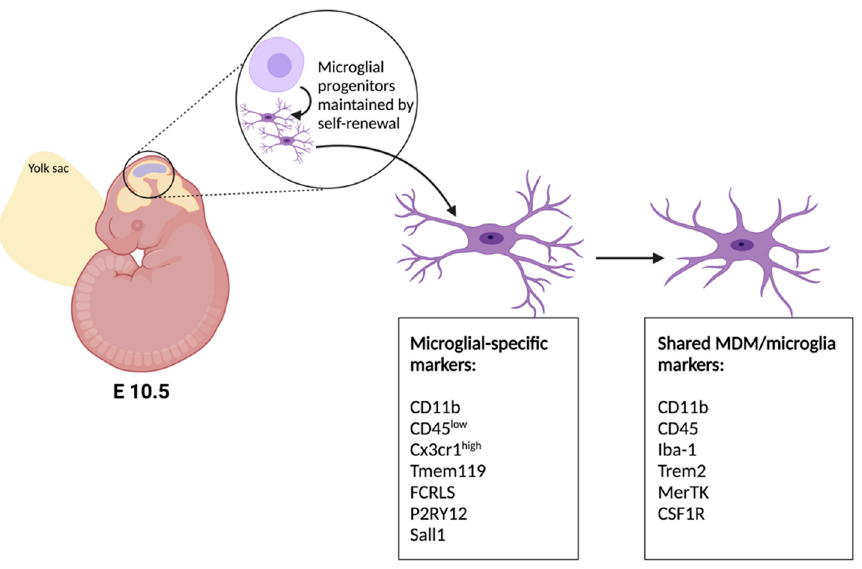
Figure 1. Developmental origins and phenotypic markers of microglia. Neuroepithelial progenitor cells give rise to microglia in mice between embryonic days 10–11. Microglial-specific markers and nonspecific markers of microglia and macrophages [18]. Table 1. Commercially available microglial marker-specific Cre-inducible mouse strains.